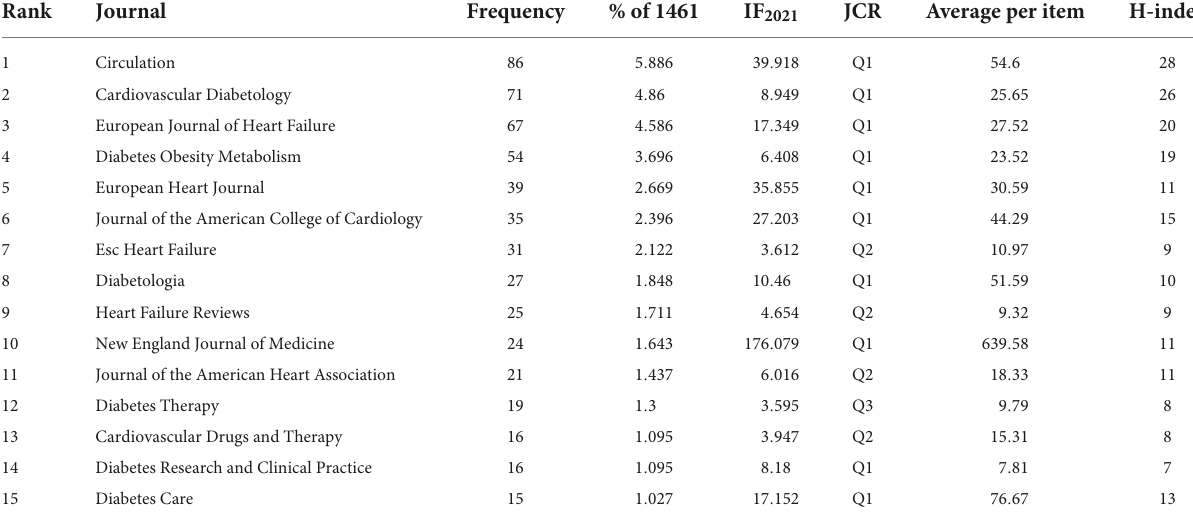
TABLE 3 Top 15 contributing journals in the field of EMPA for HF.